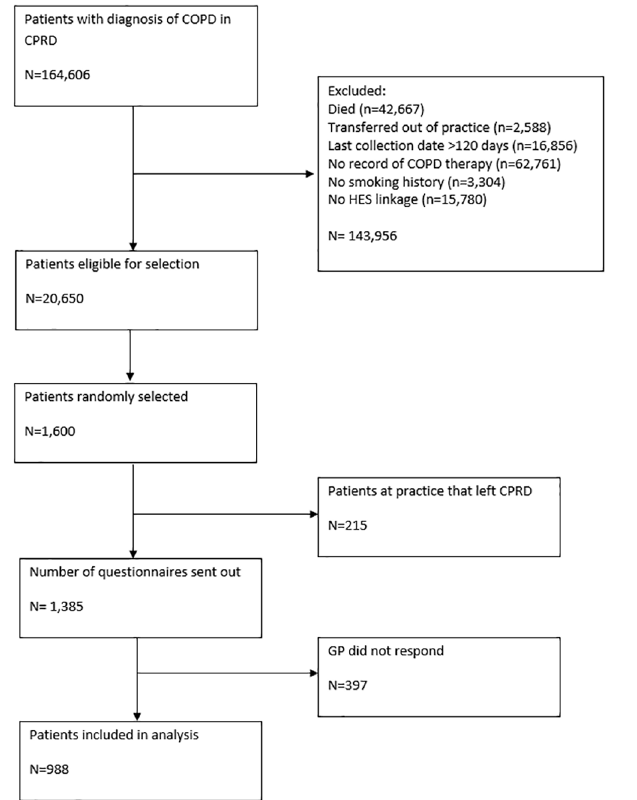
Fig 1. Patient flow through the